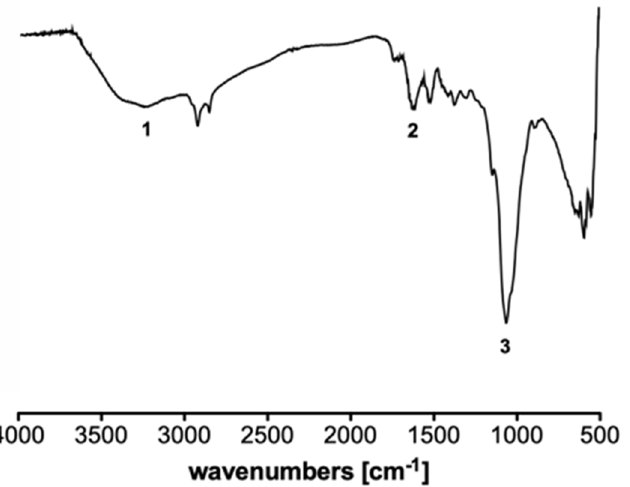
Figure 3. ATR-FTIR spectrum of the GO-CS composite aerogels in the range 4000–400 cm − 1 . (1) O- H stretching; (2) C=O stretching, (3) C-O